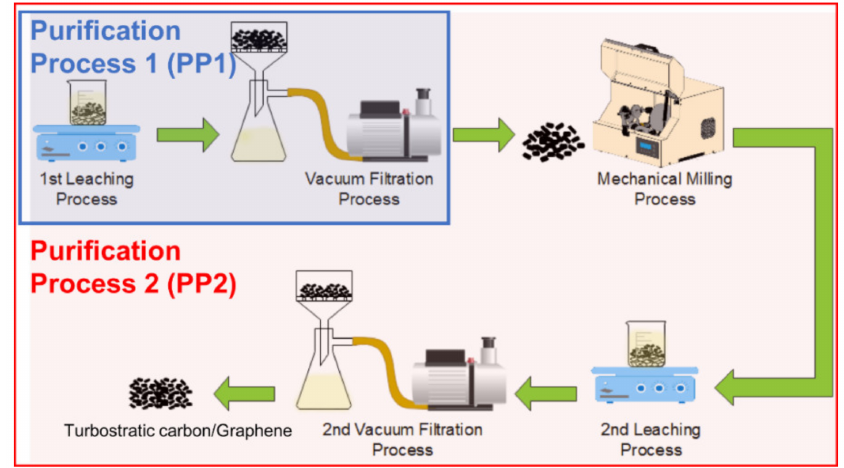
Figure 2. Illustrative diagram of sample purification